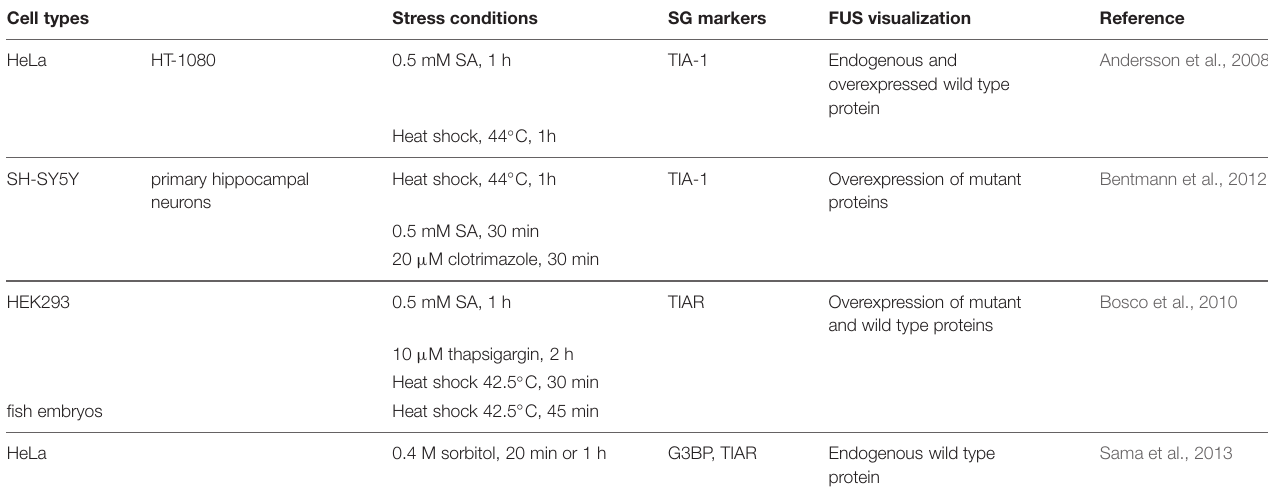
TABLE 3 | FUS localization to